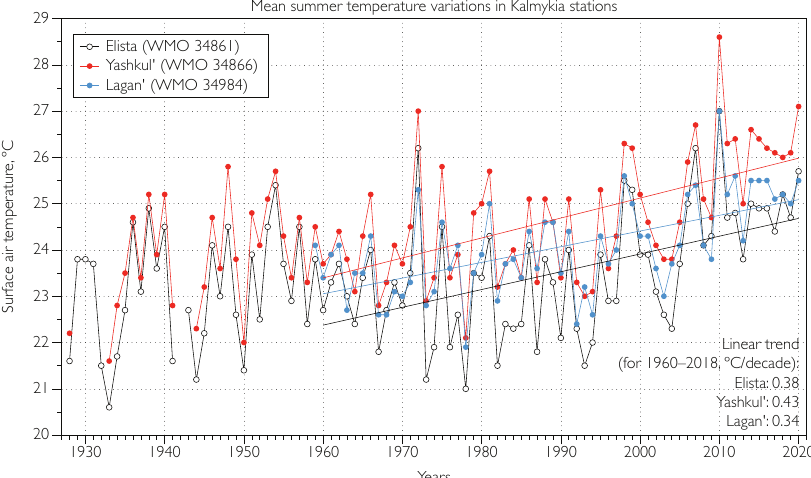
Figure 3. Variations of mean summer temperature of surface air in Kalmykia meteorological stations Lagan, Yashkul and Elista (data from [64,65]).